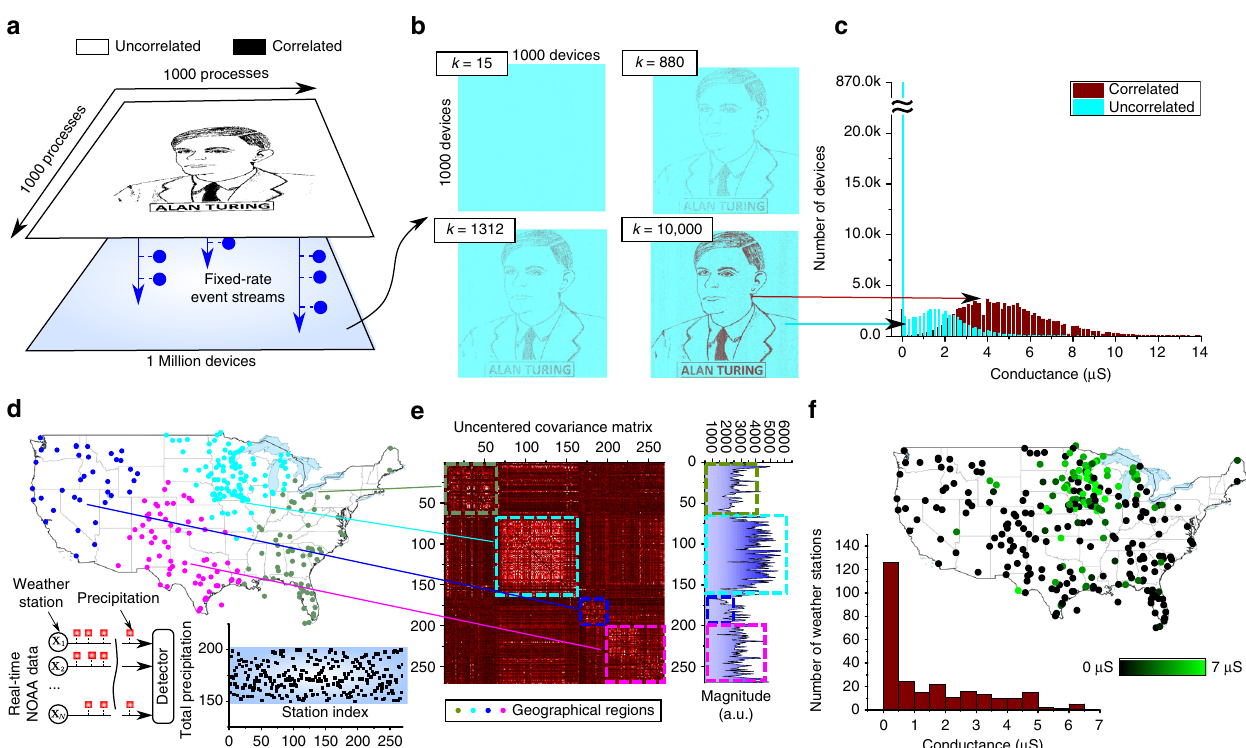
Fig. 5 Experimental results. a A million processes are mapped to the pixels of a 1000 × 1000 pixel black-and-white sketch of Alan Turing. The pixels turn on and off in accordance with the instantaneous binary values of the processes. b Evolution of device conductance over time, showing that the devices corresponding to the correlated processes go to a high conductance state. c The distribution of the device conductance shows that the algorithm is able to pick out most of the correlated processes. d Generation of a binary stochastic process based on the rainfall data from 270 weather stations across the USA. e The uncentered covariance matrix reveals several small correlated groups, along with a predominant correlated group. f The map of the device conductance levels after the experiment shows that the devices corresponding to the predominant correlated group have achieved a higher